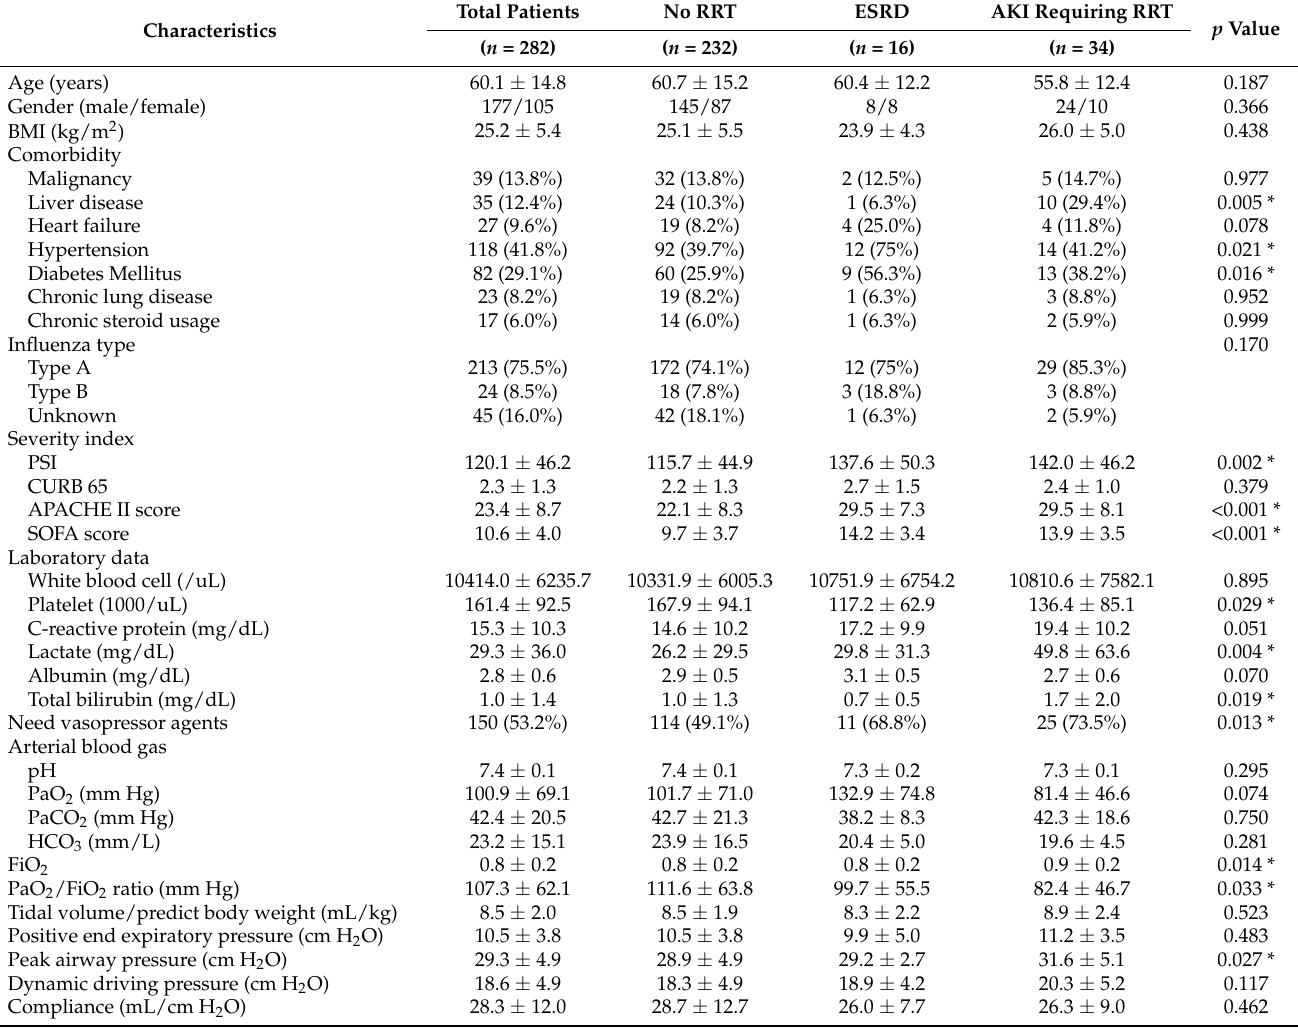
Table 1. Demography